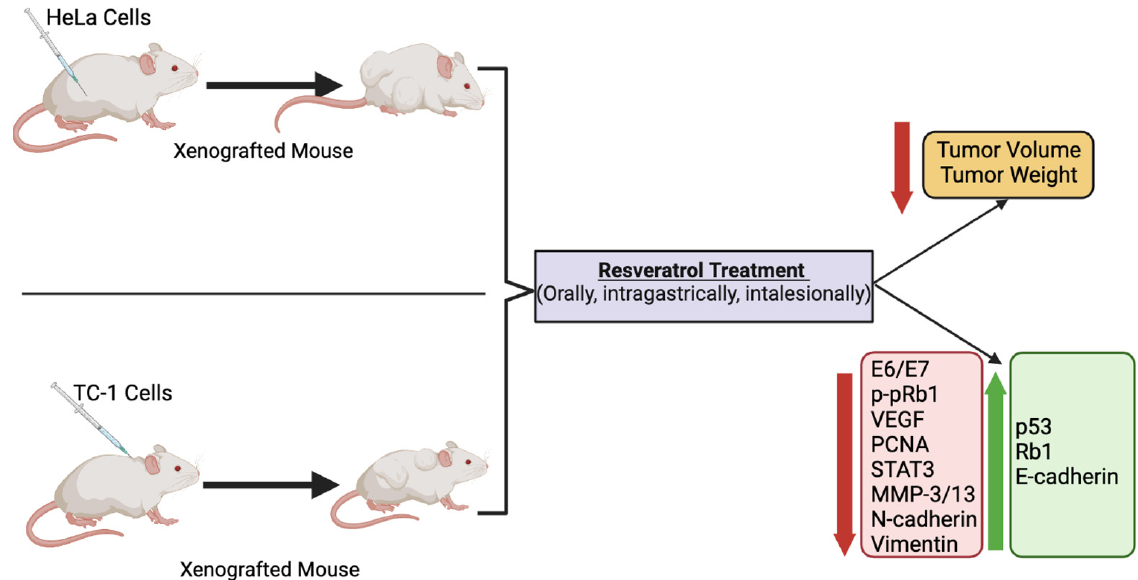
Figure 3. Summary of the effects of resveratrol in cervical cancer in animals. Treatment of animals (mice) xenografted with cervical cancer cells with RSV resulted in a significant reduction in tumor volume and weight compared to non-treated mice. The figure, created using BioRender.com, is based on the data of the studies [52,56,59,67,69].